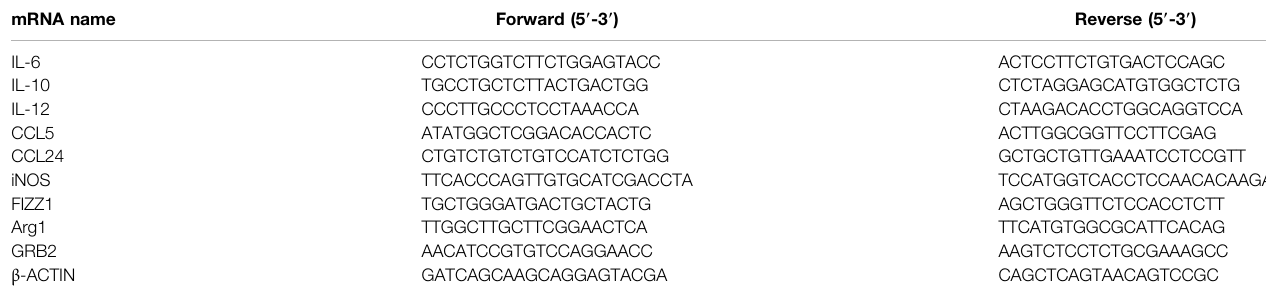
TABLE 1 | The mRNA-speci fi c primer sequences.